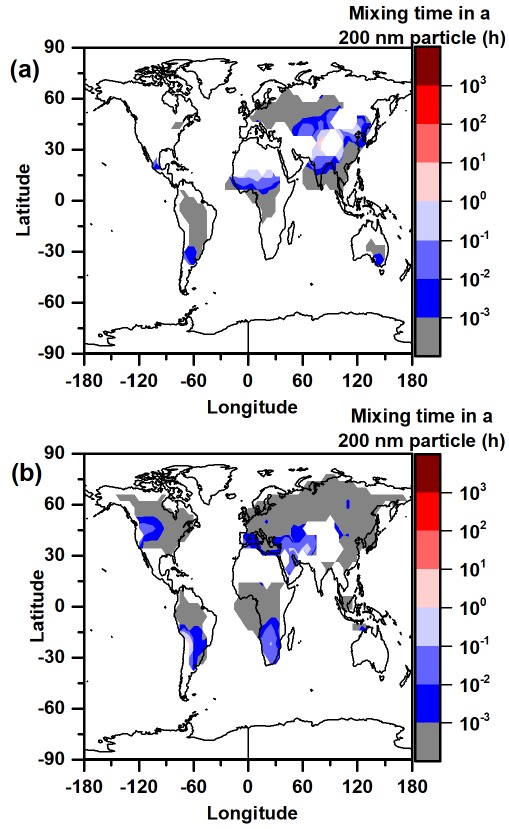
Figure 7. Plot of RH vs. temperature with contour lines represent- ing (a) the viscosity parameterization for α -pinene SOA particles based on the data from Zhang et al. (2015) and (b) mixing times calculated for organic molecules within 200nm diameter α -pinene SOA particles. The symbols in (a) represent the laboratory data used to develop the parameterization: the square represents the water vis- cosity at room temperature from Crittenden et al. (2012) and the circles represent the viscosity data from Zhang et al. (2015). The viscosity parameterization is based α -pinene SOA generated using mass concentrations of ∼ 70µgm − 3